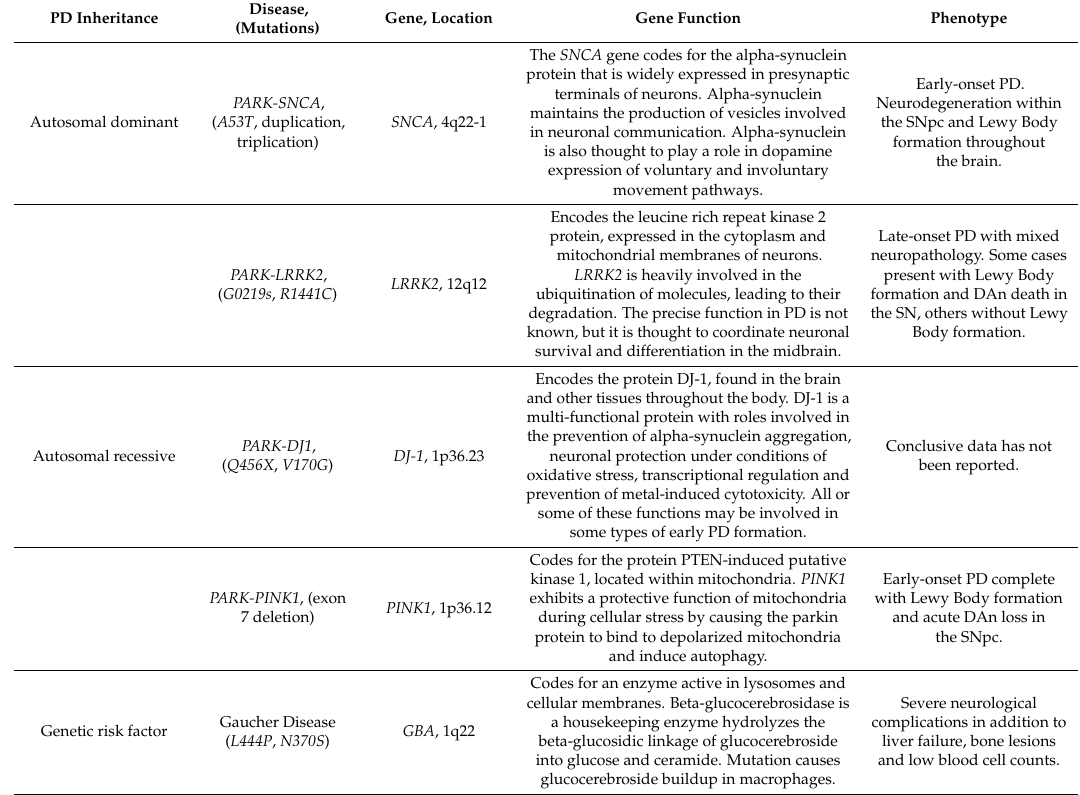
Table 1. Major Familial Forms and Genetic Factors of Parkinson’s